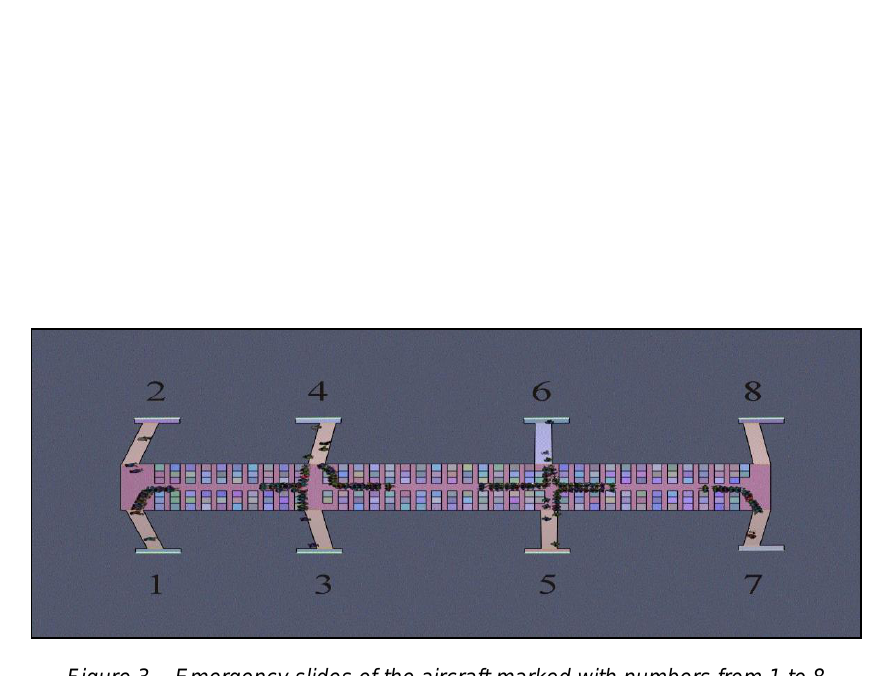
Figure 3 – Emergency slides of the aircraft marked with numbers from 1 to 8